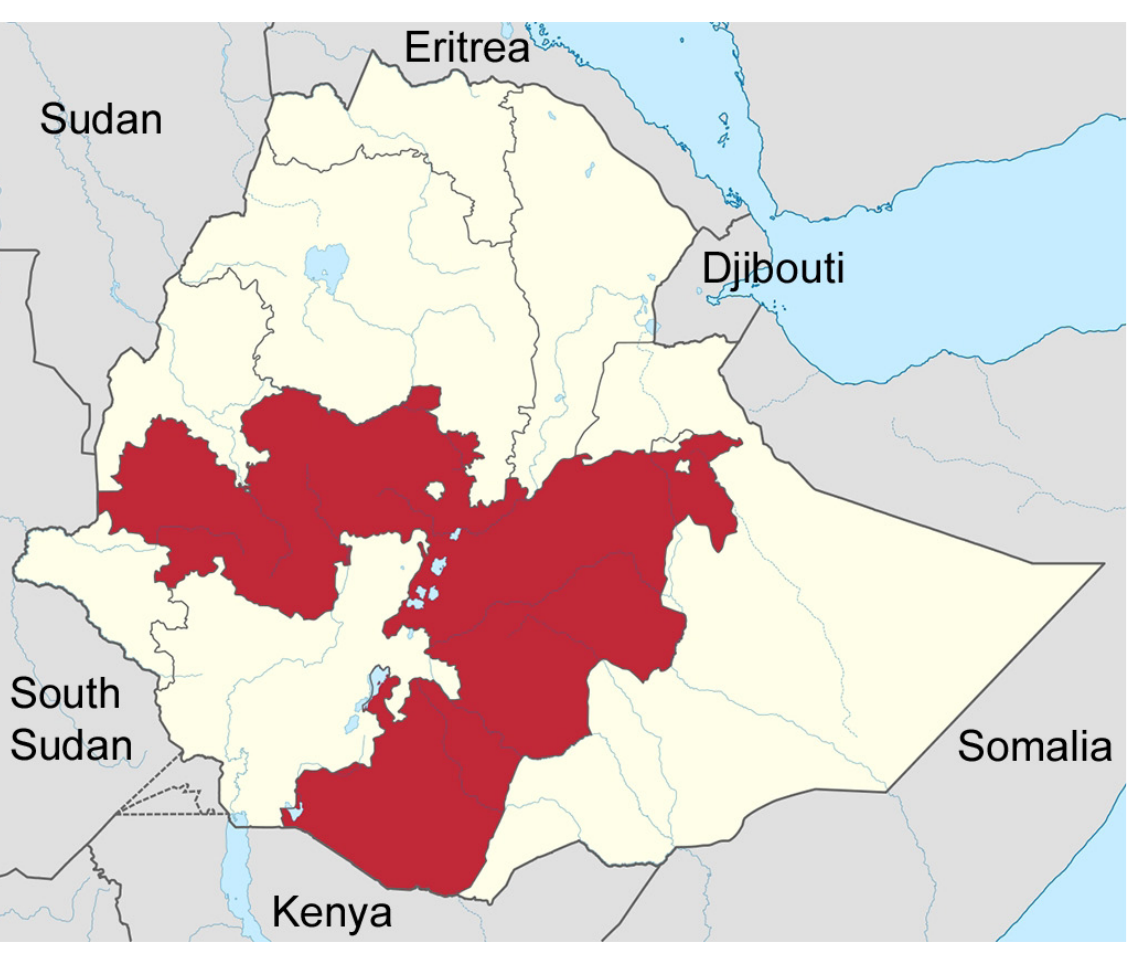
Fig. 1. The National Regional State of Oromia (red) within Ethiopia and the Horn of Africa (boundaries after MapLibrary